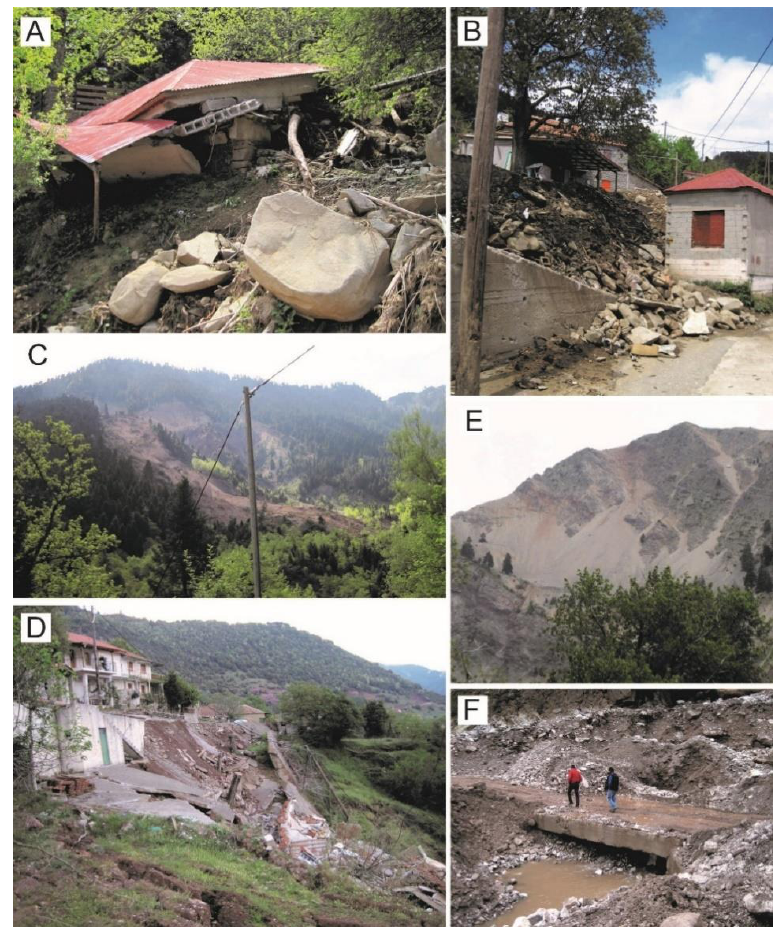
Figure 2. Landslide events triggered during a severe precipitation event that affected the study area. ( A , B ) a flow that that demolished a big part of the Abliani village; ( C ) a massive earth flow at the vicinity of Nerosirtis village; ( D ) a rotational slide that affected the lower parts of the Klepa village. Since 2015, the failure extends progressively upwards destroying the village; ( E , F ) A mas- sive debris flow effecting entire mountainsides. The 4 m high road bridge of picture F appears buried under 5 – 6 m thick debris materials.